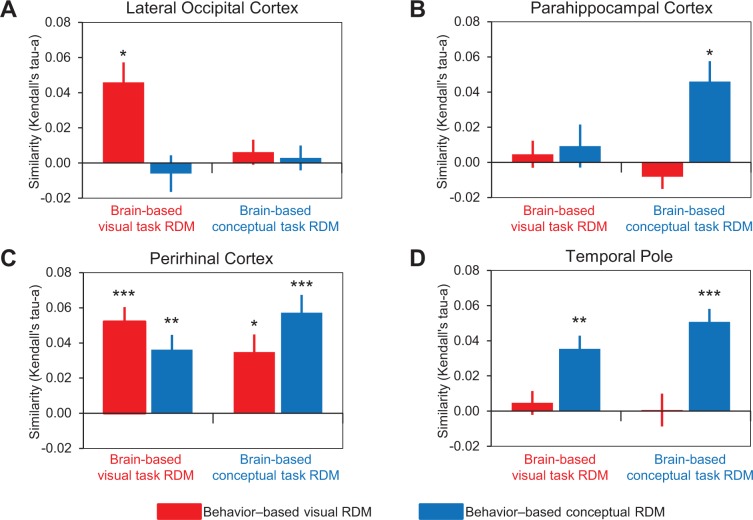
Comparison of behavior-based and brain-based RDMs.Similarities between behavior-based and brain-based RDMs are plotted for (A) LOC, (B) parahippocampal cortex, (C) PRC, and (D) the temporal pole. These comparisons are denoted by the solid vertical and diagonal arrows in Figure 5. Similarity was quantified as the ranked correlation coefficient (Kendall’s tau-a) between behavior-based RDMs and the brain-based RDMs. Error bars indicate standard error of the mean. ***p<0.001, **p<0.01, *p<0.05 (Bonferroni corrected). Participant-specific Kendall’s tau-a co-efficients are contained in Figure 6—source data 1 - Comparison of similarity models and brain-based RDMs.10.7554/eLife.31873.012Figure 6—source data 1.Comparison of similarity models and brain-based RDMs.